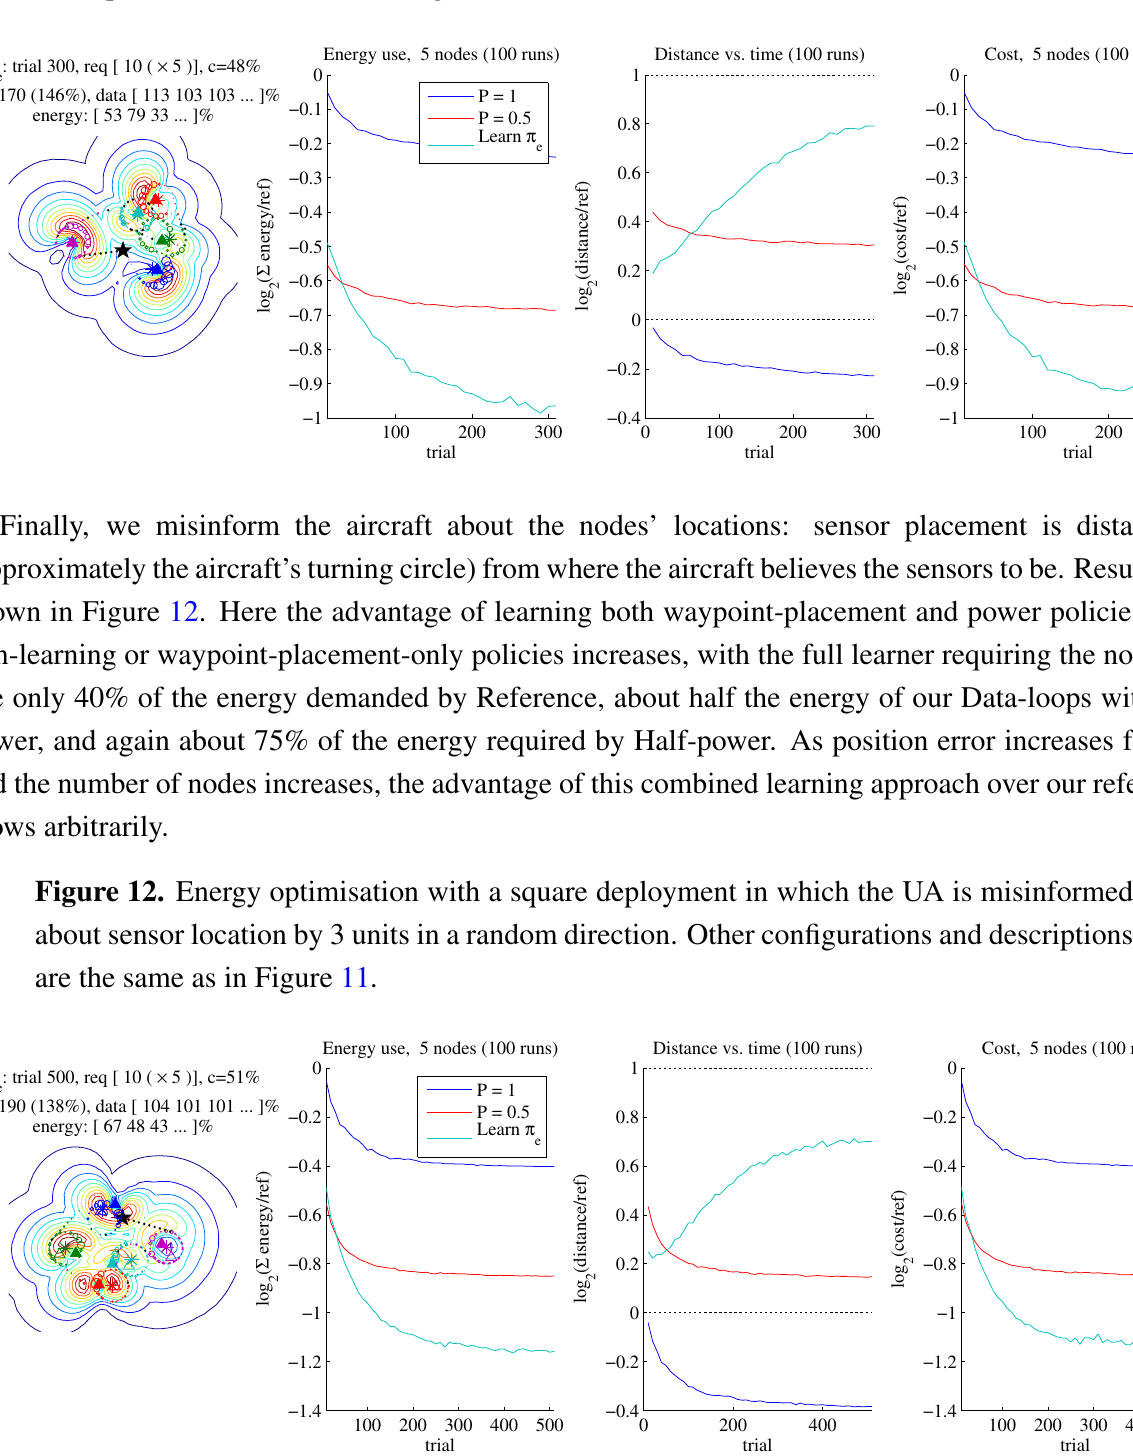
Figure 11. Node energy use on 5 nodes, square deployment. Other configurations and descriptions are the same as in Figure 10.